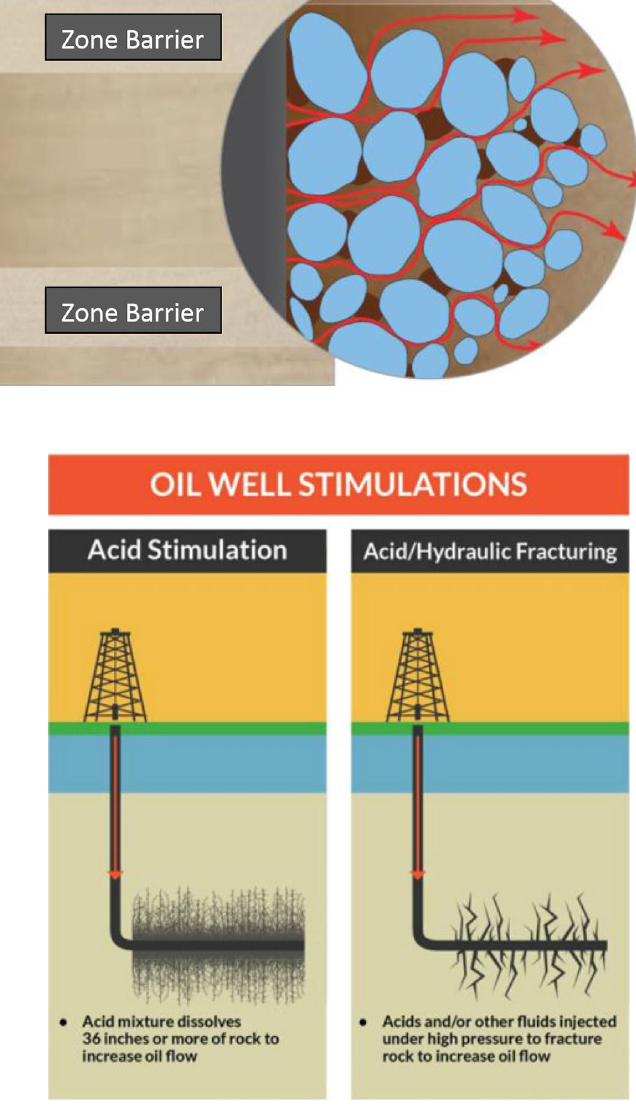
Fig. 2 Oil well stimulation illustration